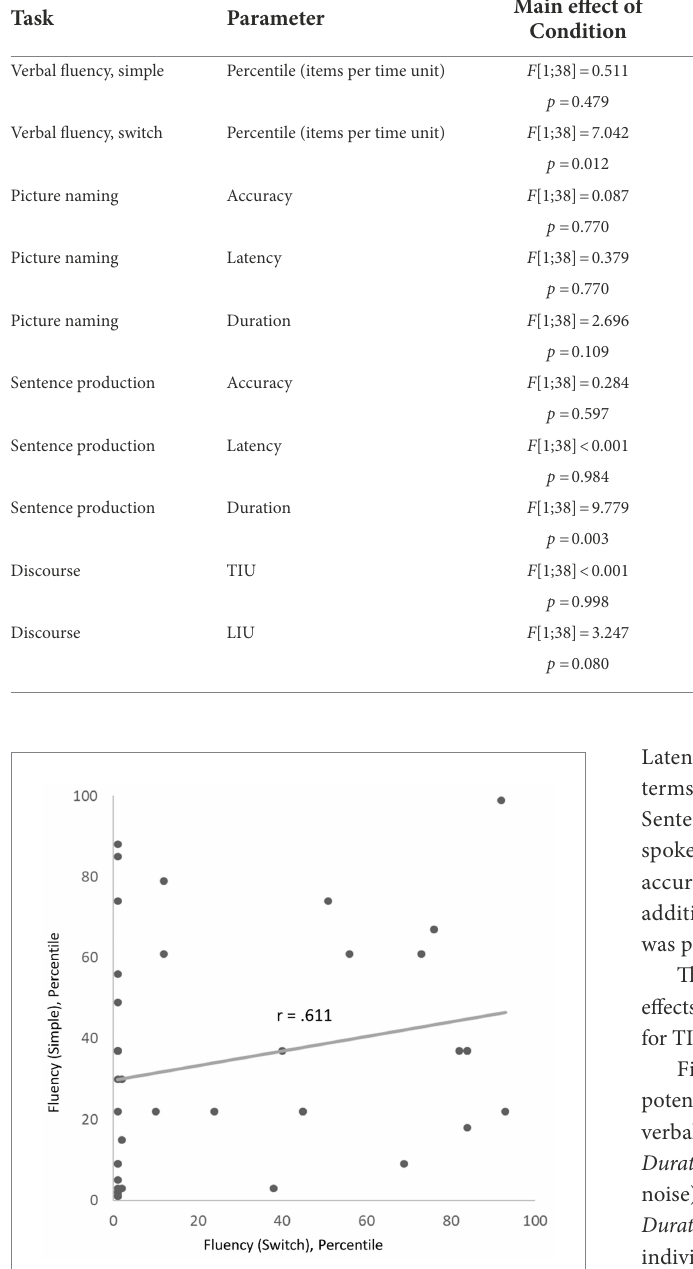
FIGURE 2 Scatter plot of the individual performance under mimicked auditory verbal hallucinations in the simple (y-axis) and the switch (x-axis) conditions of the verbal fluency